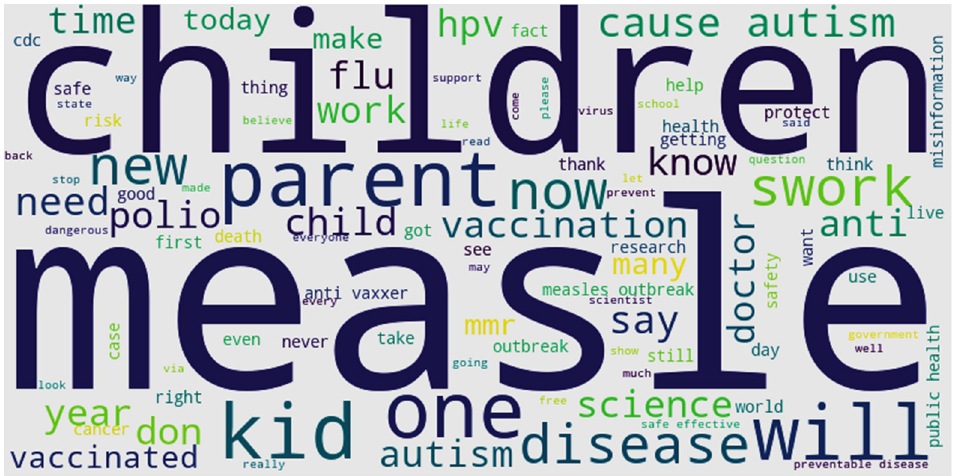
Figure 8. Word cloud of content.